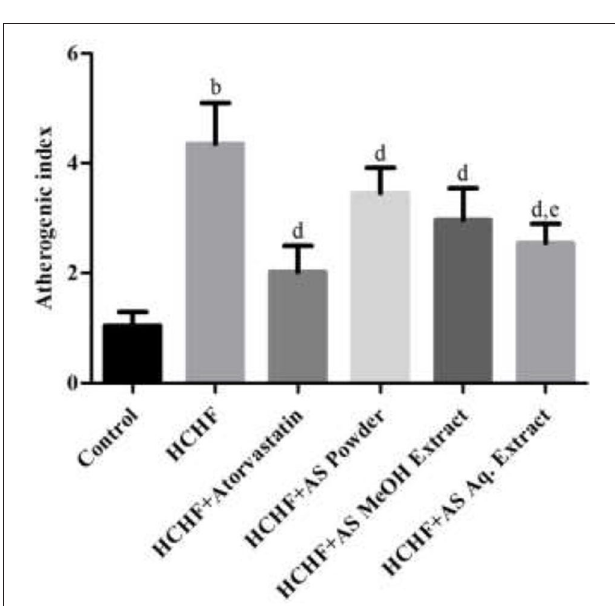
FIGURE 3 | Atherogenic indexes in control and experimental groups. Values are presented as mean ± SD, where n = 5. b p < 0.005 vs. control; d p